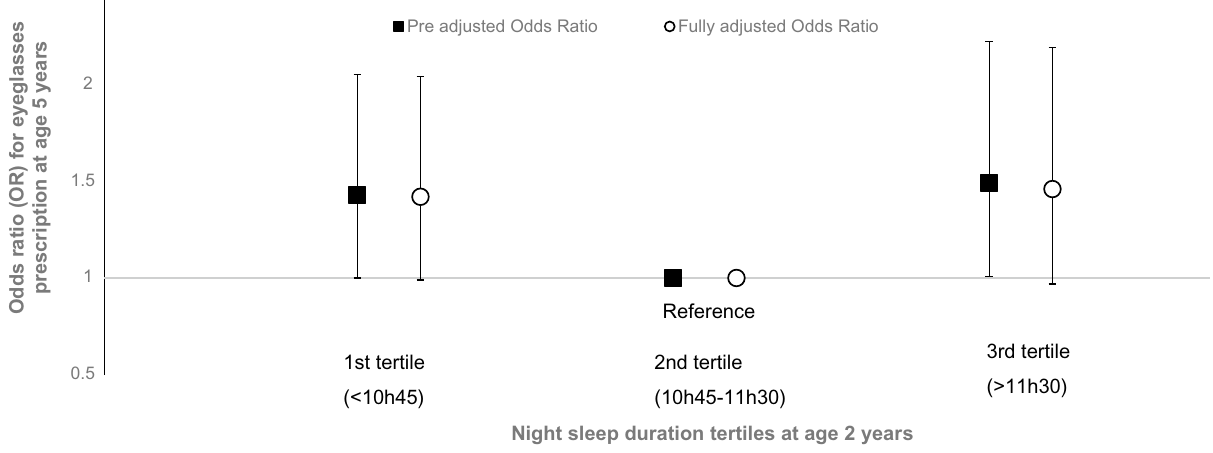
Figure 1. Odds ratios for eyeglasses prescription at age 5 according to sleep duration at age 2 (N =